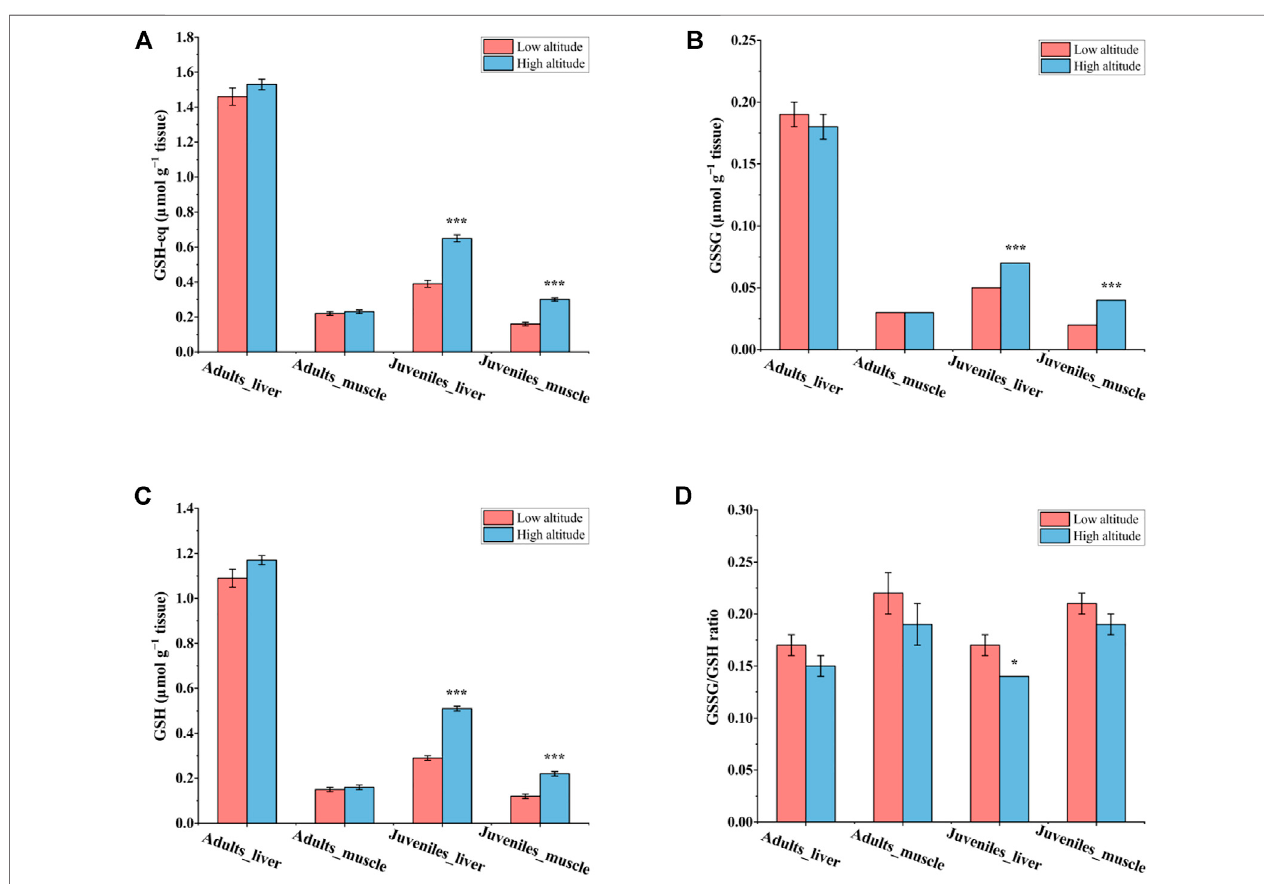
FIGURE 2 | Glutathione status in the liver and skeletal muscle of N. parkeri adults and juveniles at low and high altitude, respectively. (A) GSH-eq, (B) GSSG, (C) GSH, (D) GSSG/GSHratio.Totalglutathioneequivalents(GSH-eq)areGSH+2GSSG.Thedataareexpressedasthemeans±SEM( n =8)in μ mol g − 1 tissue.Student ’ s t-tests for independent samples were used to test for signi fi cant differences between the two altitudes (* p < 0.05, *** p < 0.001).